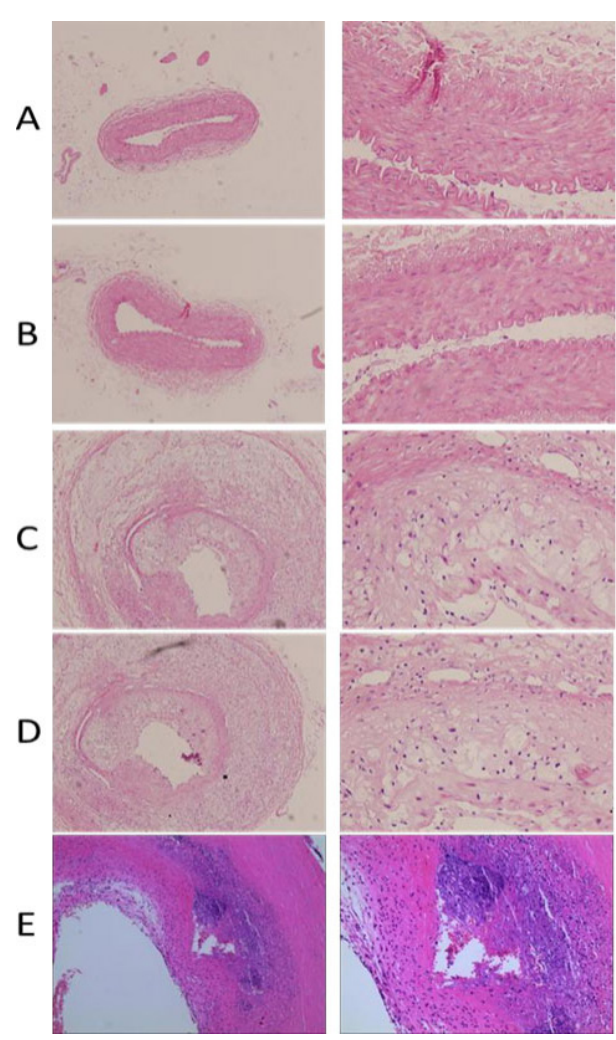
Fig. 1 - Histopathological changes in the five groups. A, B, C, D, and E represent the pure high-fat group, the sham operation group, the vulnerable plaque group, the empty load group, and the fat mass and obesity-associated gene knockdown group, respectively. From left to right, the magnification was 10× and 40×.